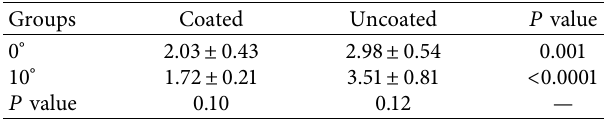
Figure 4: (a) The cracks appeared after the three-point bending test was performed (magnification: 950x). (b) The Zn layer is shown under the SEM after the friction resistance test was performed (magnification: 5.50kx). Table 2: Mean ± SD of friction resistance values ( N ) in coated and uncoated